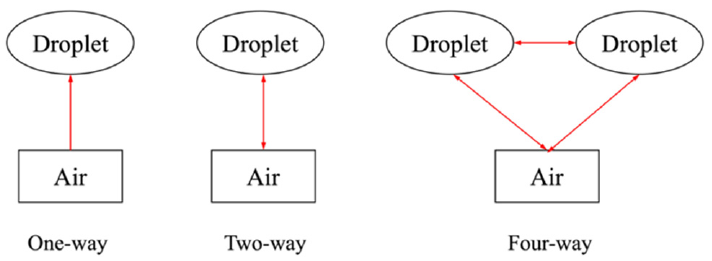
Figure 3. Different levels of interaction between air and droplet.